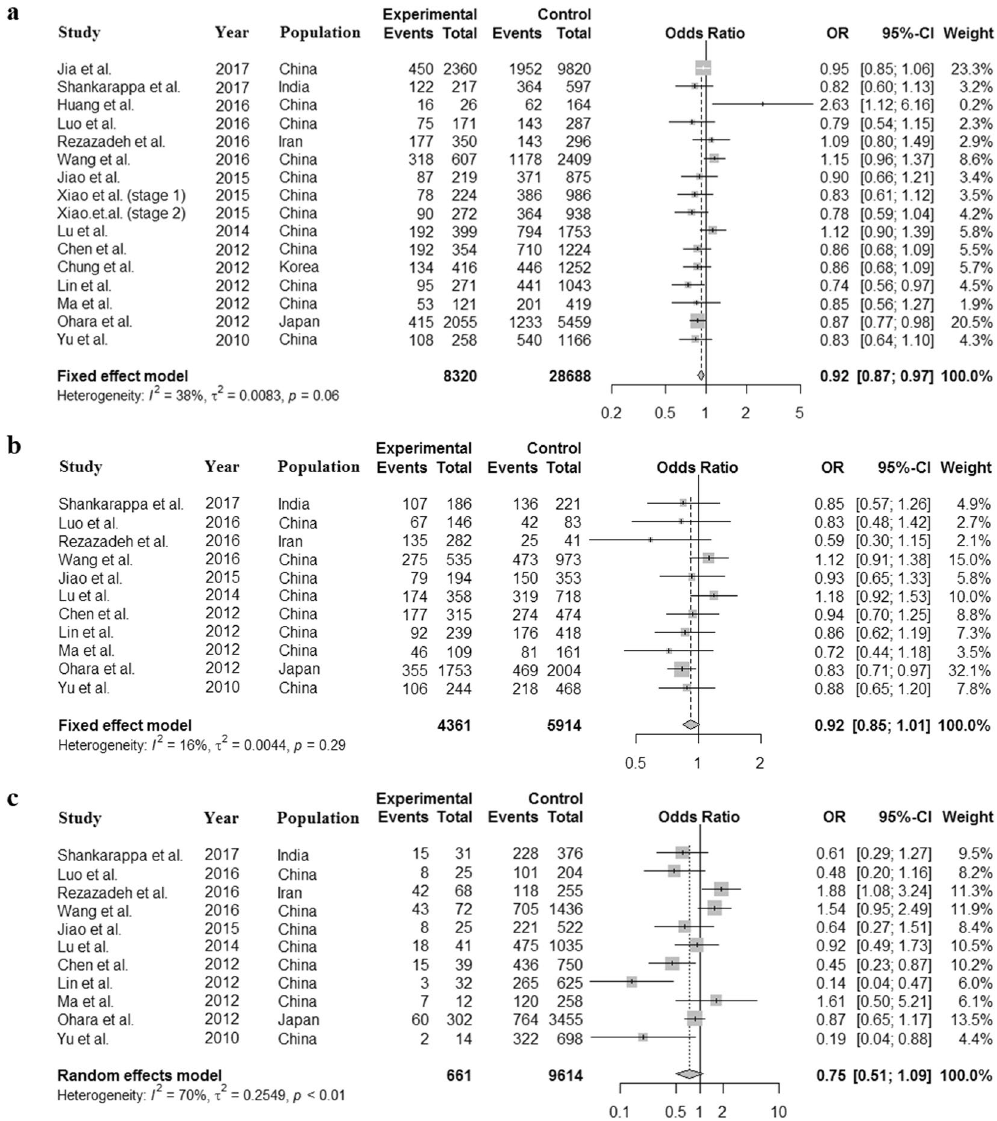
Figure 3. Forest plot for the meta-analysis of rs11136000 polymorphism in Asian population. Only a weak association between rs11136000 polymorphism and AD is observed in the allele model ( a ), but not the dominant ( b ) and recessive model ( c